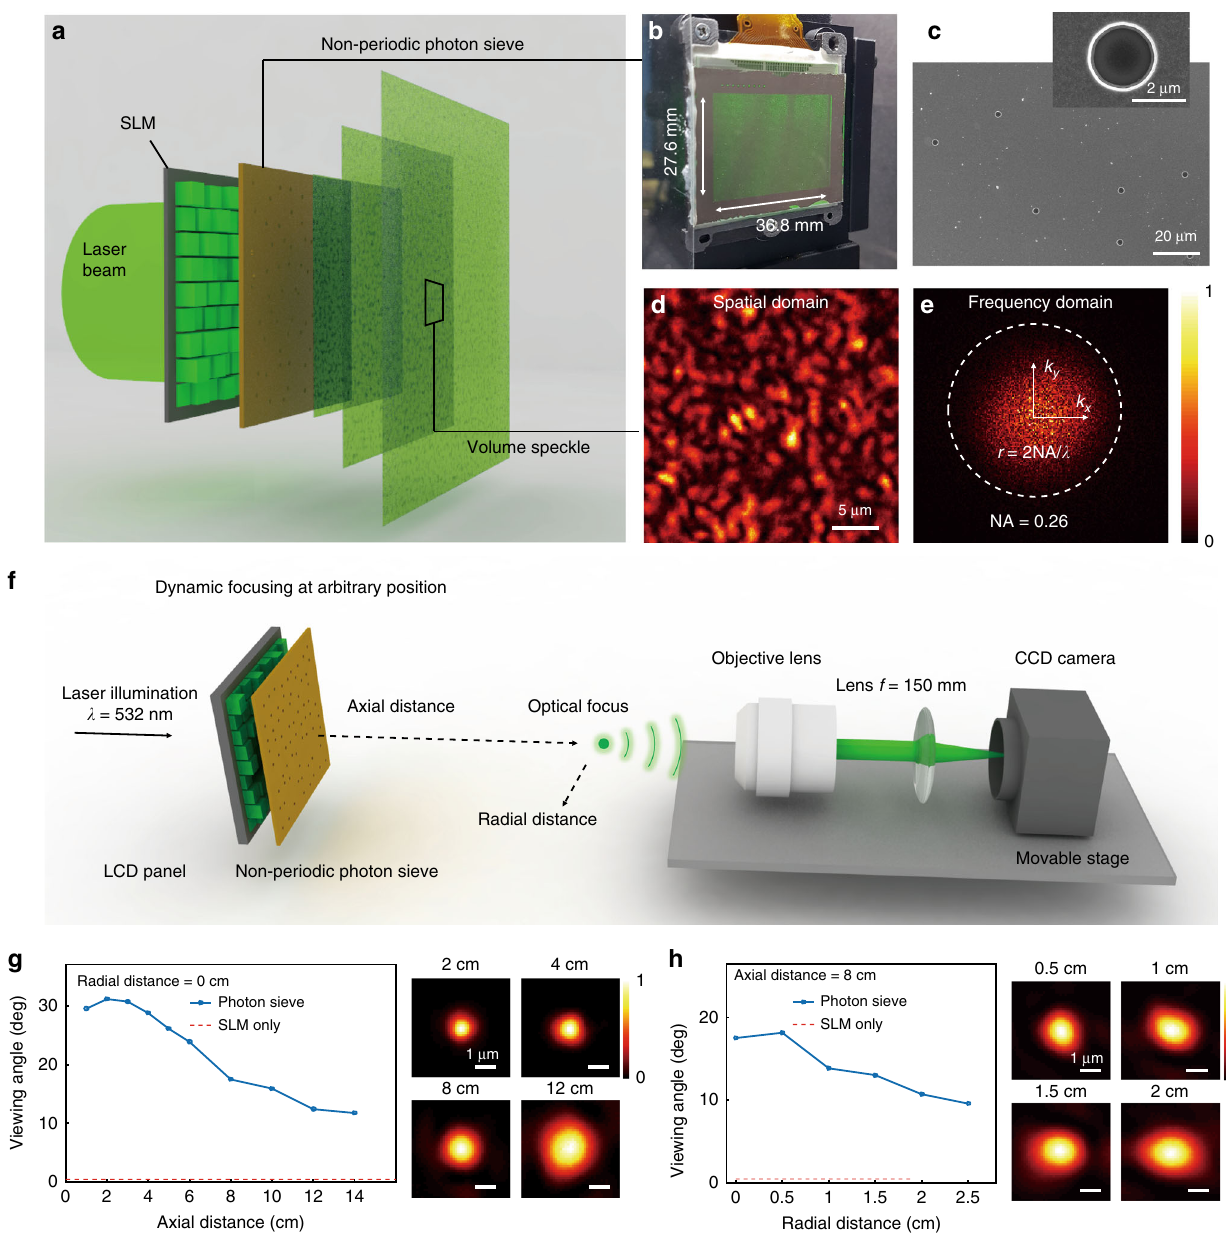
Fig. 2 Wide-angle large-area holographic display using non-periodic photon sieve. a Scheme of the system. The non-periodic photon sieve increases the diffraction angles of transmitting light. A one-to-one correspondence between SLM pixels and pinholes allows independent modulation of the optical fi eld transmitted from each pinhole. b Photograph of the system. The pinholes are placed close to the transmissive SLM to maintain the small form factor. c Micrographs from a scanning electron microscope of the non-periodic photon sieve fabricated using conventional photolithography. The diffraction angles of the transmitting light fi eld vary according to the pinhole size. d Intensity pro fi le of light transmitted through the non-periodic photon sieve. The size of the pinholes in the photon sieve is 2.2 μ m. The distance between the image plane and the photon sieve is 10 mm. e Spatial frequency map corresponding to the intensity pattern of the image in d . The dashed circle indicates the numerical aperture corresponding to the viewing angle of 30 degrees. f Scheme of dynamic optical focusing over a wide volume. Optical focus is generated at arbitrary positions by displaying optimal patterns at the LCD panel. A 4- f telescopic imaging system (NA = 0.75) is mounted on a movable stage to capture images. g , h The size and shape of the focus vary according to its position because the addressable transversal wave vector depends on the displaying geometry. Effective viewing angles of the foci were examined from the size of the